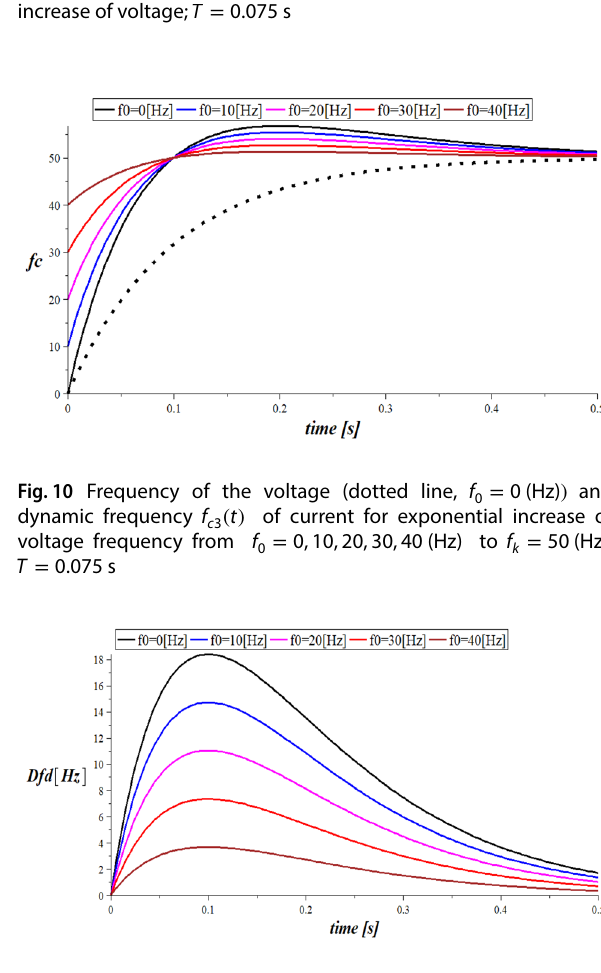
Fig. 11 Dynamic overshoot of frequency of currents 𝛥 f d , for exponential increase of voltage frequency f v 3 ( t ) , from f 50 (Hz) ; T = 0.075 (s) 0,10,20,30,40 (Hz) to f k = 0 =